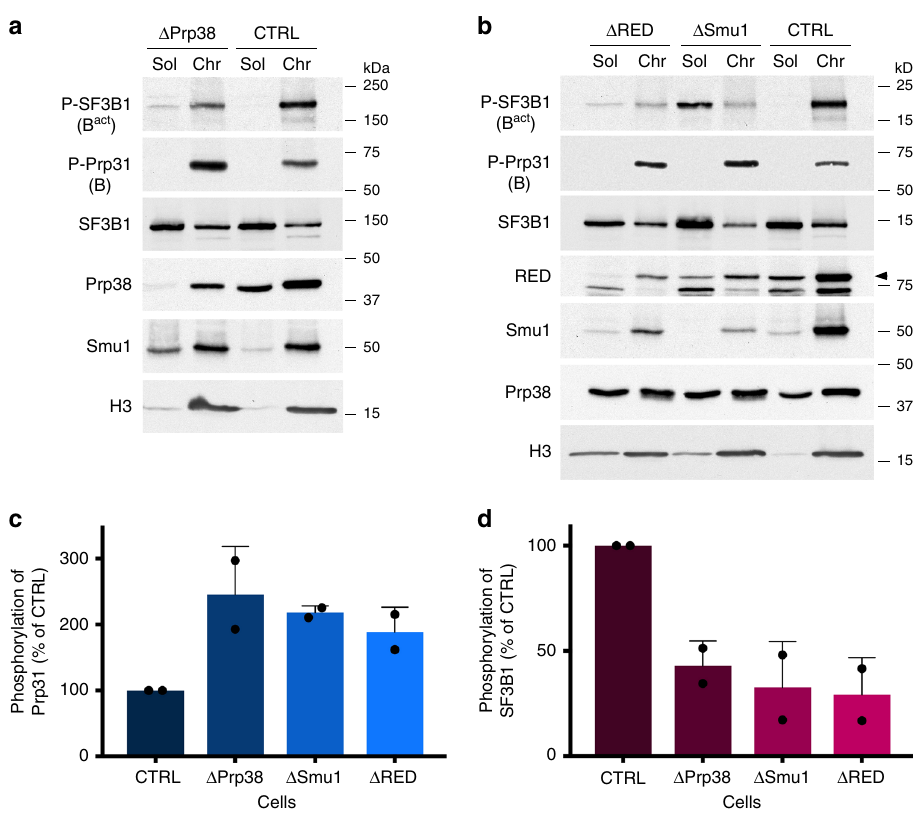
Fig. 7 Smu1 and RED knockdowns alter the levels of phosphorylated Prp31 and SF3B1 in vivo. a , b Control HeLa cells (CTRL) or cells depleted of a Prp38 or b Smu1 and RED by RNAi were fractionated into a soluble (Sol) or chromatin (Chr) fraction. Equal amounts of each fraction were analysed by Western blot using antibodies against phosphorylated (P) SF3B1 or phosphorylated Prp31, SF3B1 (both phosphorylated and non-phosphorylated), Histone 3B (H3), RED, Smu1 or Prp38. c , d Quanti fi cation of phosphorylation levels of c Prp31 or d SF3B1 in CTRL or knockdown cells as indicated on the X -axis. The signal of the corresponding protein in the control lane was set to 100%. Error bars represent the standard deviation obtained from two independent experiments. The enhanced P-SF3B1 signal in the soluble nuclear fraction after Smu1 knockdown is likely due to dissociation during fractionation of less stable spliceosomes leading to leakage. Data points are shown as black dots. Error bars represent the standard deviation obtained from two independent experiments. Source data are provided as a Source Data fi